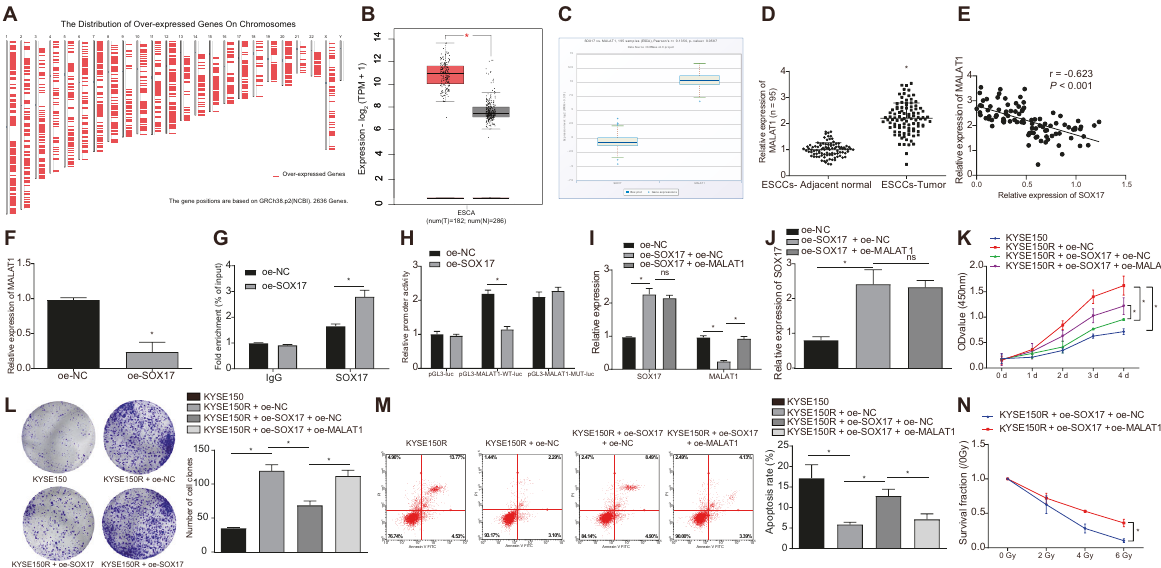
Fig. 3 SOX17 suppressed the radioresistance of ESCC cells via transcriptional inhibition of MALAT1. A Chromosome map showing location of 2636 DEGs which were signi fi cantly overexpressed in ESCC. B A box plot of MALAT1 expression in normal samples and ESCC samples. Red box represents cancer samples, and gray box represents normal samples. C The co-expression relationship between SOX17 and MALAT1 in ESCC samples. D, MALAT1 expression in tumor tissues (ESCC-Tumor group) and adjacent normal tissues (ESCC-Adjacent normal group) from ESCC patients as measured by qRT-PCR. n = 95 in ESCC patients. E Correlation analysis of MALAT1 expression and SOX17 mRNA expression in tumor tissues of 95 ESCC patients analyzed by Pearson correlation analysis. F The expression of MALAT1 in KYSE150R cells in oe-NC group and oe-SOX17 group as examined by qRT-PCR. G MALAT1 binding to SOX17 in KYSE150R cells of oe-NC group and oe-SOX17 group measured by ChIP assay. H The luciferase activity of MALAT1 promoter in 293T cells of oe-NC group and oe-SOX17 group measured by dual luciferase reporter assay. I The expression of SOX17 and MALAT1 in KYSE150R cells in response to oe-SOX17 alone or combined with oe-MALAT1 examined by qRT-PCR. J The protein expression of SOX17 in KYSE150R cells in response to oe-SOX17 alone or combined with oe-MALAT1 measured by Western blot. K, The survival rate of KYSE150R cells in response to oe-SOX17 alone or combined with oe-MALAT1 measured by MTT assay. L The proliferation ability of KYSE150R cells in response to oe-SOX17 alone or combined with oe-MALAT1 examined by clonogenic assay. M The apoptosis of KYSE150R cells in response to oe-SOX17 alone or combined with oe-MALAT1 measured by fl ow cytometry. N The proliferation ability of KYSE150R cells in response to oe-SOX17 alone or combined with oe-MALAT1 examined by clonogenic assay. * p < 0.05. Measurement data were expressed as mean ± standard deviation. Paired t test was employed to compare the difference between tumor tissues and adjacent normal tissues. Unpaired t test was adopted to analyze the other data between two groups. One-way ANOVA followed by Tukey ’ s post-hoc test was used for comparison between multiple groups. Two-way ANOVA with Bonferroni post-hoc test was employed to analyze the data between groups at different time points. Cell experiments were repeated in